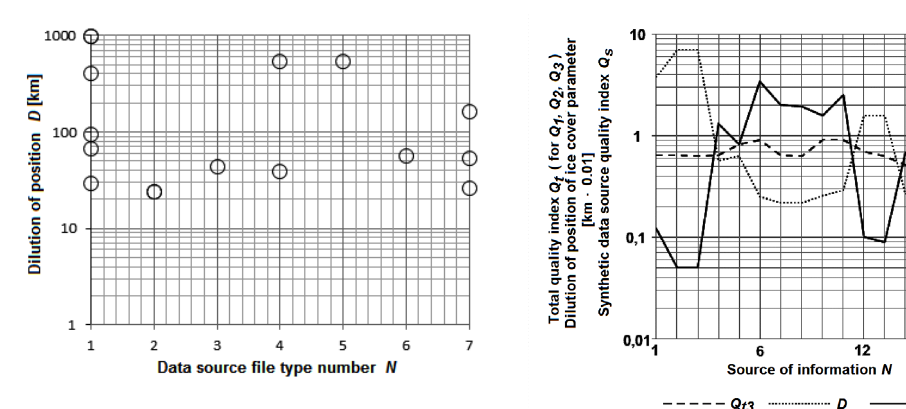
Fig. 3. Value of dilution of position D for the succes- sive groups of data sources N : 1 – raster graphic files, 2 – vector files ESRI Shape type with simplified scale of data (MIZ), 3 – vector files KMZ type with